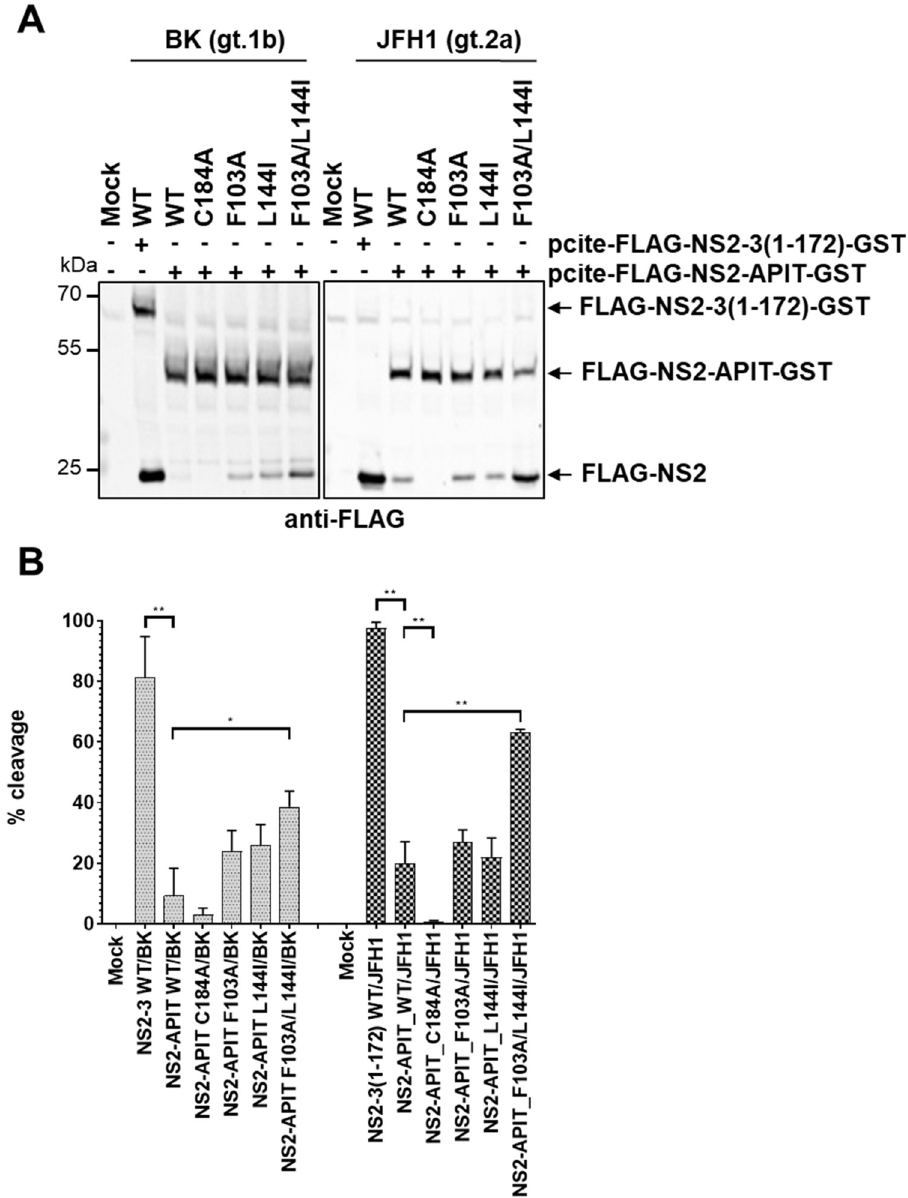
Fig 5. The amino acid exchanges F103A and L144I lead to a stimulation of the intrinsic NS2 pro cleavage efficiency in the absence of the NS3 cofactor in two different HCV genotypes. (A) Analysis of the intrinsic NS2 pro activity in the MVA/T7 pol expression system in Huh7-T7 cells. NS2-mediated cleavage of FLAG-NS2-NS3(1–172)-GST or FLAG-NS2-APIT-GST polyprotein fragments was analyzed by Western blotting using FLAG-specific antibodies. One representative blot from three independent experiments is shown. Molecular mass standards are shown on the left. Positions of the uncleaved precursors FLAG-NS2-NS3(1–172)-GST or FLAG-NS2-APIT-GST and cleavage product FLAG-NS2 are indicated by arrows on the right. (B) Quantification of NS2-protease mediated cleavage efficiencies (percent of cleavage calculated as percent of cleavage product over the sum of uncleaved precursor plus cleaved product) from lysates subjected to immunoblotting using infrared fluorescent-labeled secondary antibodies and the Odyssey SA imaging system ( LI-COR ). Background was subtracted from FLAG-specific signals of uncleaved precursors and cleavage product using the corresponding signal of the mock sample. Mean and standard deviation of NS2 pro cleavage efficiencies from three independent experiments are presented. WT: wild-type; mock: transfection control without plasmid DNA. Asterisks indicate statistically significant differences in comparison to WT ( � p < 0.05; �� p < 0.01).